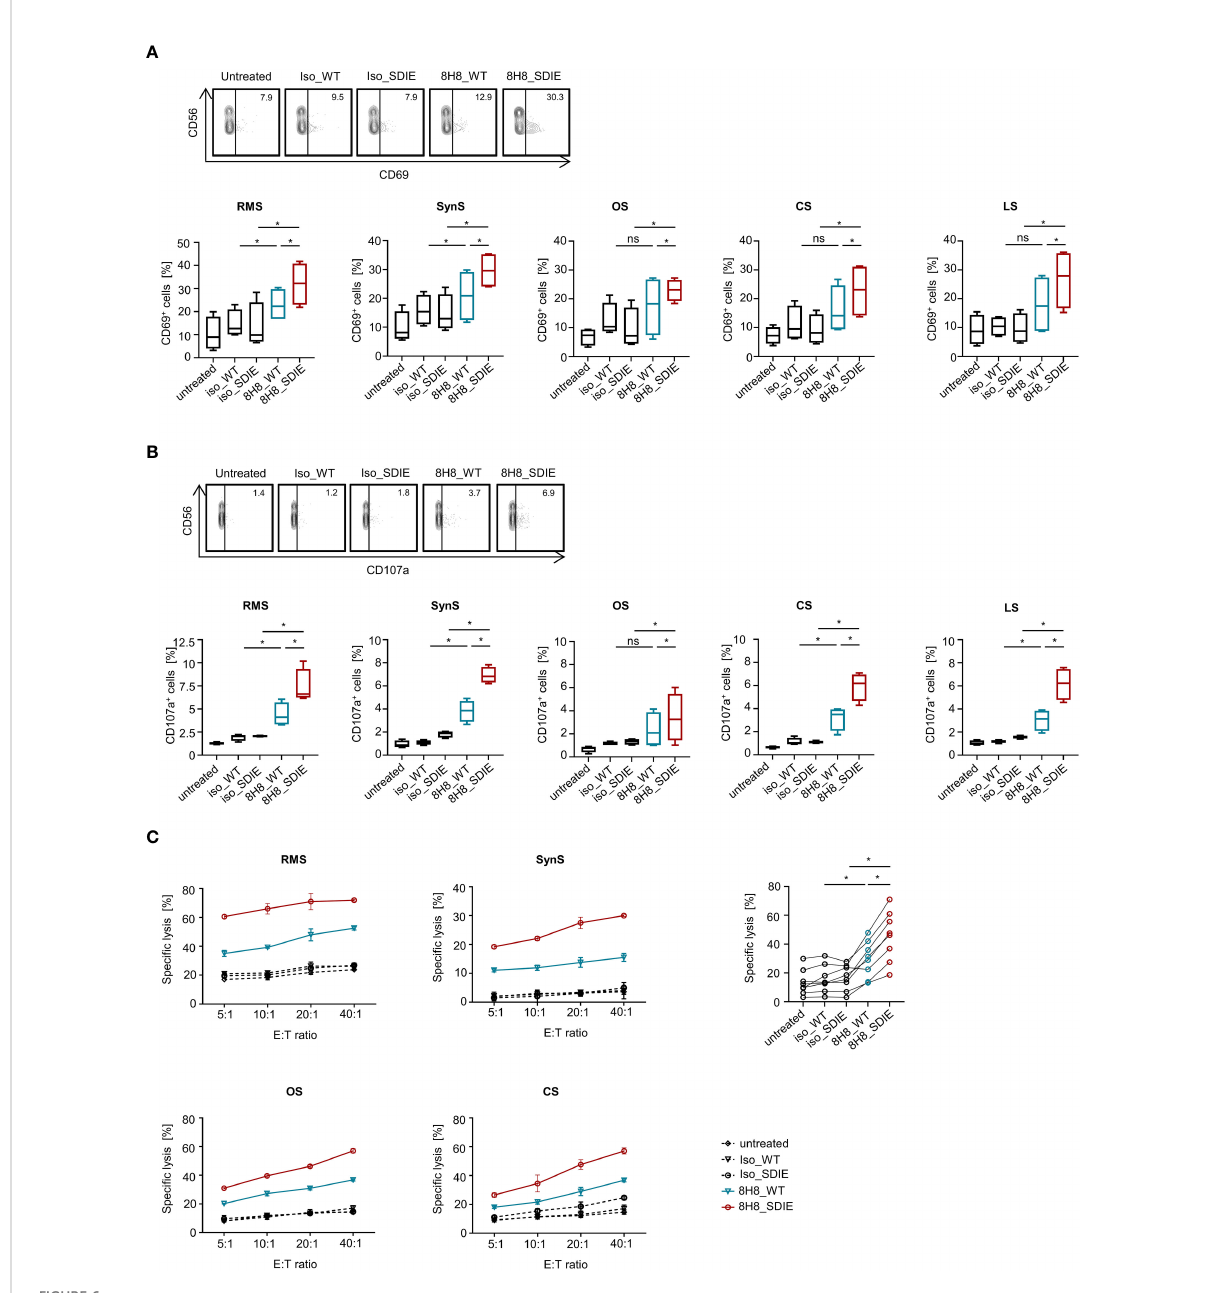
FIGURE 6 8H8_SDIE induces NK cell reactivity and cytotoxicity against patient-derived sarcoma cells. PBMC of healthy donors were incubated with patient-derived sarcoma cells of different subtypes and treated with the indicated B7-H3 antibodies or the corresponding isotype controls (1 m g/ mL). (A) Activation of NK cells was determined by expression of CD69 after 24h. In the top panels, exemplary fl ow cytometry results obtained with patient-derived synovialsarcoma cells and one PBMC donor and in the bottom panel, combined data with patient-derived sarcoma cells (n=5) and with PBMC of four different donors (n=4) are shown. (B) Degranulation of NK cells was determined by expression of CD107a after 4h. In the upper panels, exemplary fl ow cytometry results obtained with patient-derived rhabdomyosarcoma cells and one PBMC donor and in the lower panel, data with patient-derived sarcoma cells (n=5) and with PBMC of four independent donors (n=4) are shown. (C) Killing of patient- derived sarcoma cells (n=4) was analyzed by 2 h Europium cytotoxicity assays. In the left panels, exemplary data obtained with PBMC of one healthy donor and patient-derived rhabdomyosarcoma, osteosarcoma, synovialsarcoma and chondrosarcoma cells as indicated with different E: T ratios and on the right, pooled data obtained with PBMC of healthy donors (n=2) and patient-derived sarcoma cells (n=4) at an E:T ratio of 20:1 are shown. ns, not signi fi cant; *statistically signi fi cant differences (p-value <